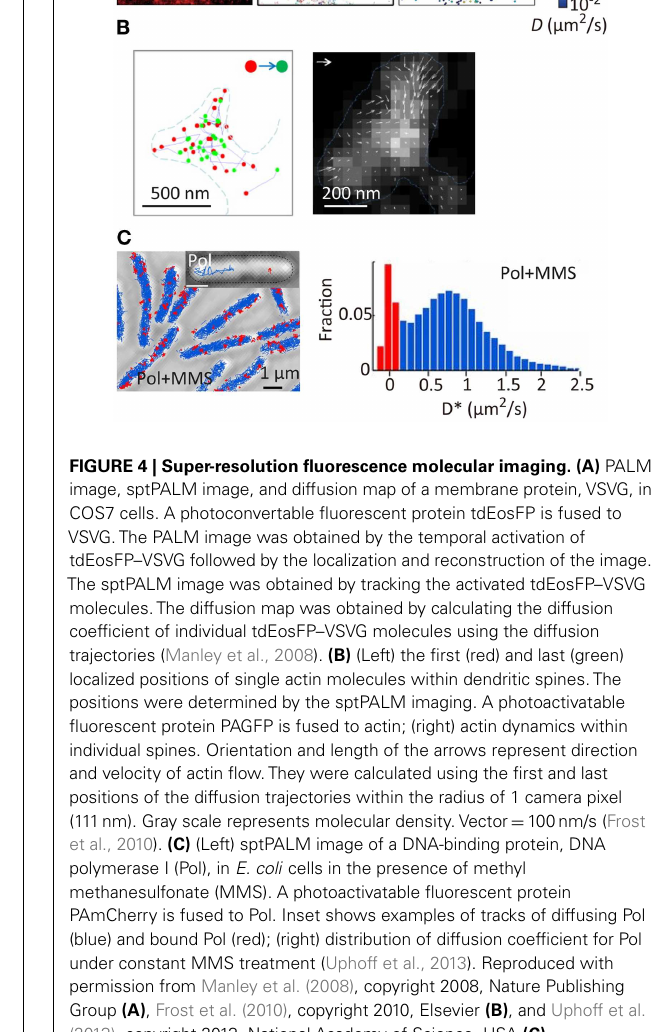
FIGURE 3 | Quantitative super-resolution fluorescence imaging. (A) (Top left) PALM image of transferrin receptor (TfR) across the plasma membrane of COS7 cells. A photoactivatable fluorescent protein PAGFP is fused toTfR; (top right) plot of calculated autocorrelation function [ g ( r ) peaks ] of PAGFP molecules in the PALM image. g ( r ) stoch and g ( r ) protein are the correlation owing to multiple appearances of a single protein and the protein correlation.The cluster size and average numbers of the molecule in clusters are estimated by a fitting of the autocorrelation plot with an exponential decaying function; (bottom) size and number of molecules in clusters of a transmembrane protein, Lat (Sengupta et al., 2011). (B) (Top) bright-field microscopy, wide-field fluorescence microscopy, and PALM images of a flagellar motor protein, FliM, in bacterial cells. A photoconvertable fluorescent protein Dendra2 is fused to FliM; (bottom) frequency histogram of number of FliM molecules in each cluster determined using the Fermi activation with optimal tolerance time (blue bars).The red bars show the histogram without optimizing the tolerance time (Lee et al., 2012). Reproduced with permission from Sengupta et al. (2011), copyright 2011, Nature Publishing Group (A) , and Lee et al. (2012), copyright 2012, National Academy of Science, USA (B) .